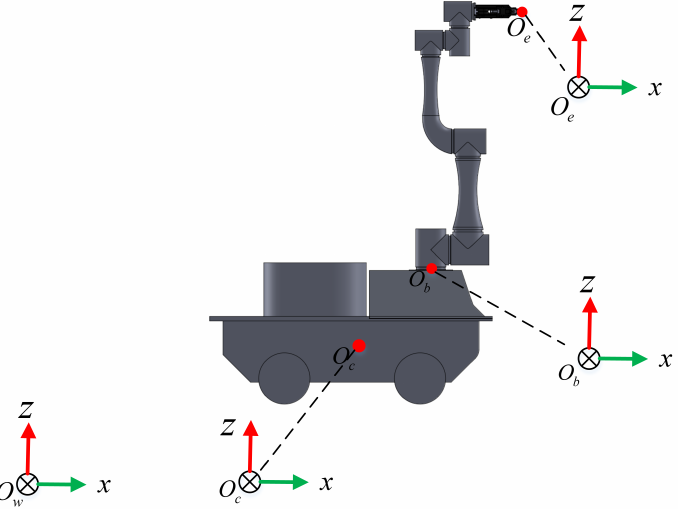
Figure 1. The physical structure of the mobile manipulator